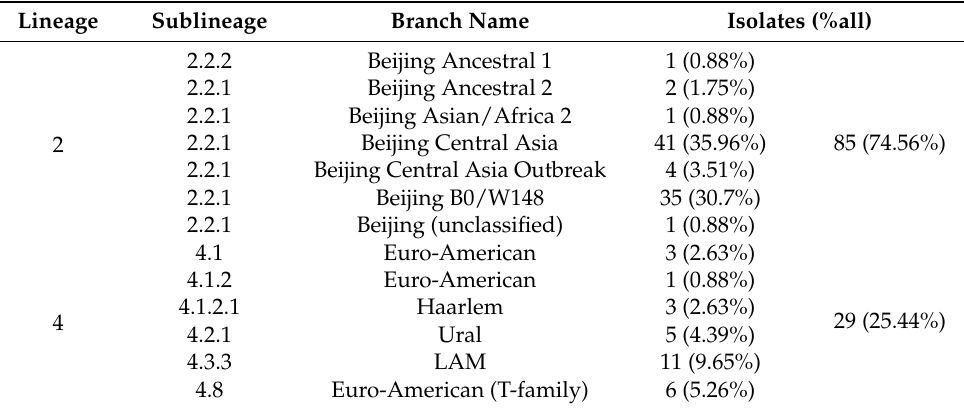
Table 1. Lineage and sublineage distribution of MTB strains, n =